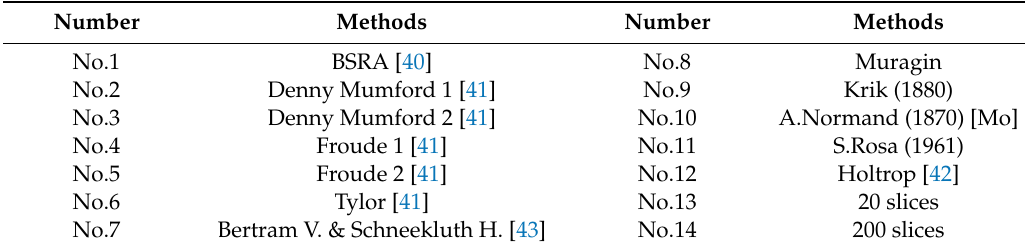
Table 4. The estimation methods of